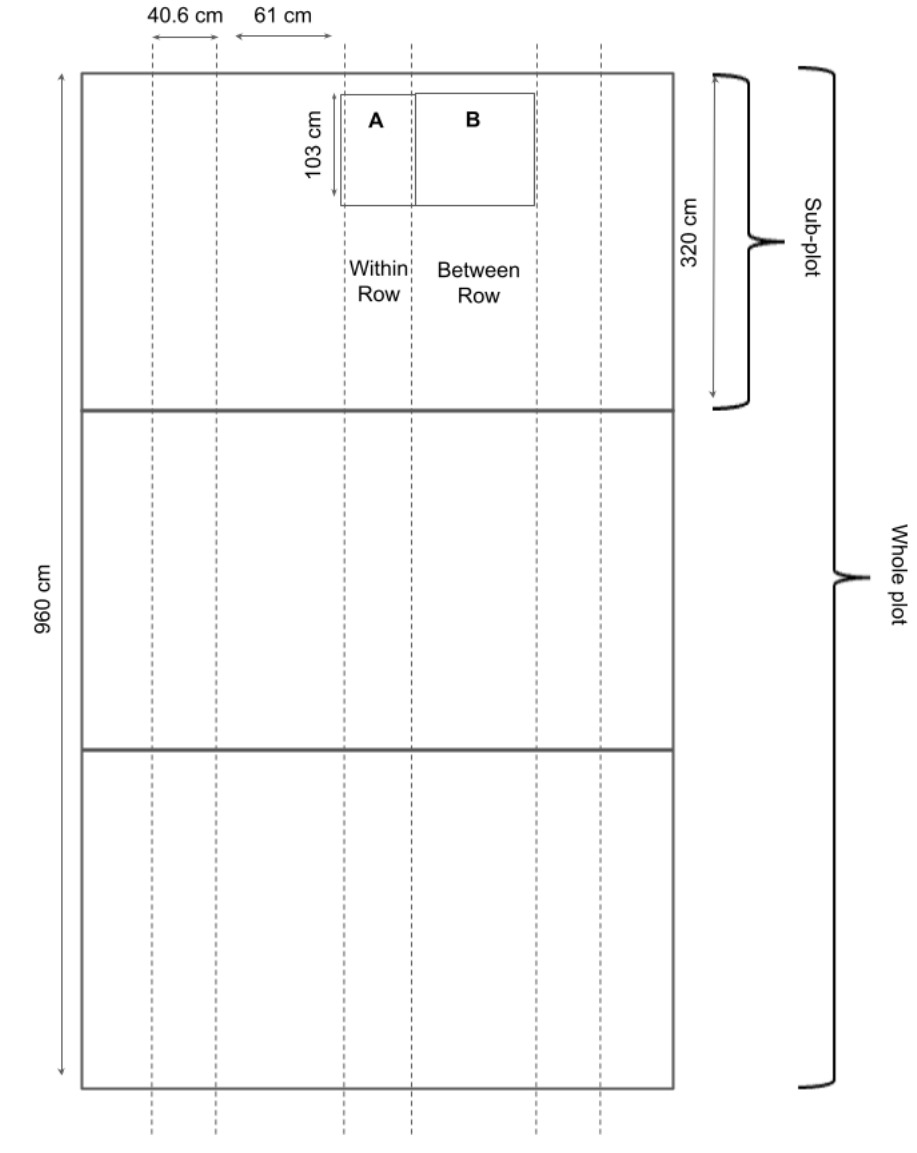
Figure 1. A diagram indicating three sub-plots within the main-plot boundary (thick solid line) positioned in relation to rows sown with IWG (dashed lines) and labeled with within and between row spaces. Boxes labeled A and B represent the sampled area within and between rows, respectively within sub-plots. Objects are not to scale. Table 1. Timing of field study management activities and treatment application from